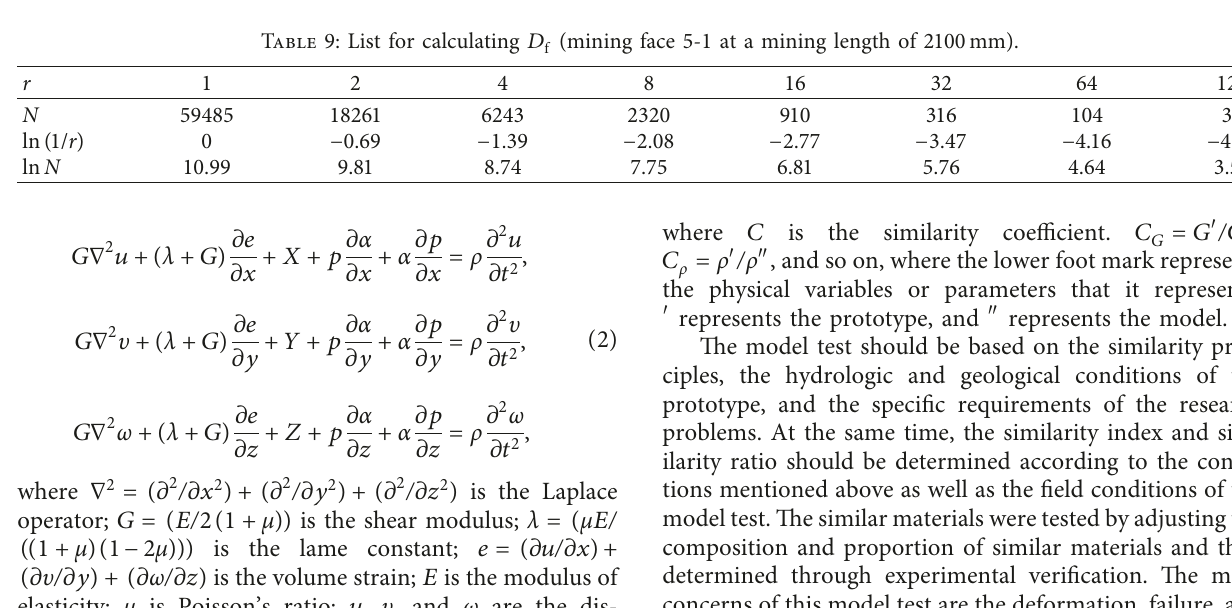
Table 7: List for calculating D